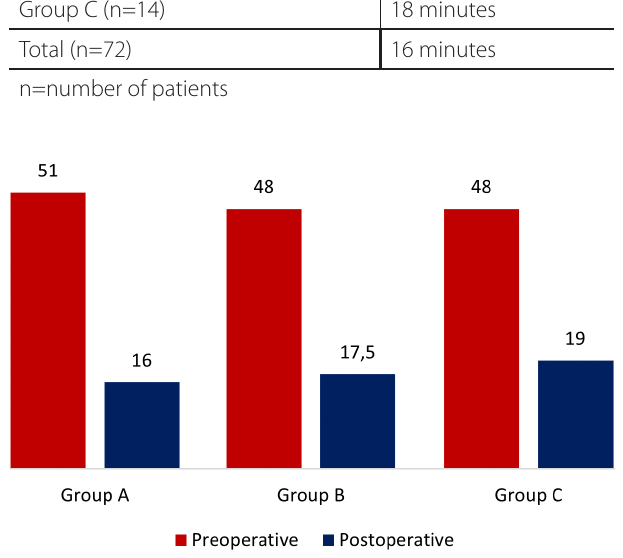
Fig. 1 - Median pre and postoperative aortic arch gradients (in mmHg) for each